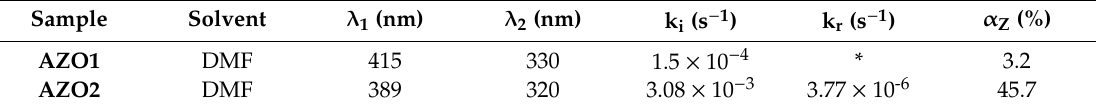
Table 2. Wavelength maxima and experimentally measured rate constants for isomerization (k i ), reverse isomerization (k r ) and the content of the Z-isomer at the PSS ( α Z ). AZO1 and AZO2 optical properties comparison. * = the obtained value is not reliable because it is falling within the experimental uncertainty of the instrument (see text).